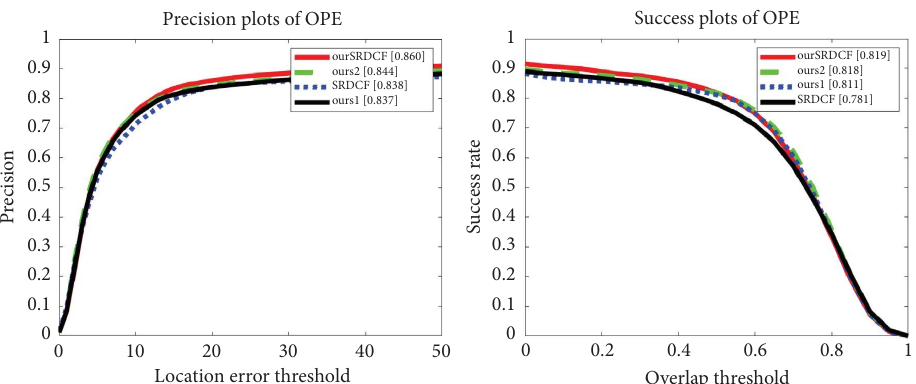
Figure 12: Quantitative evaluation of ablation experiments based on the OTB-2015